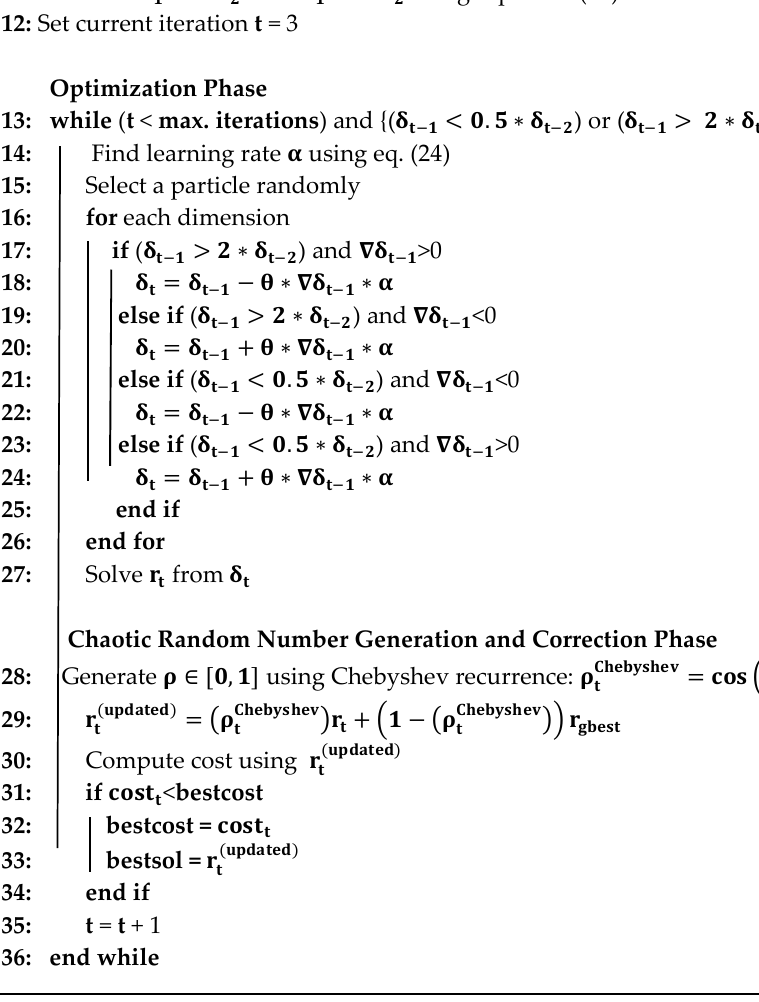
Table 1. General terms used in context of the algorithms and